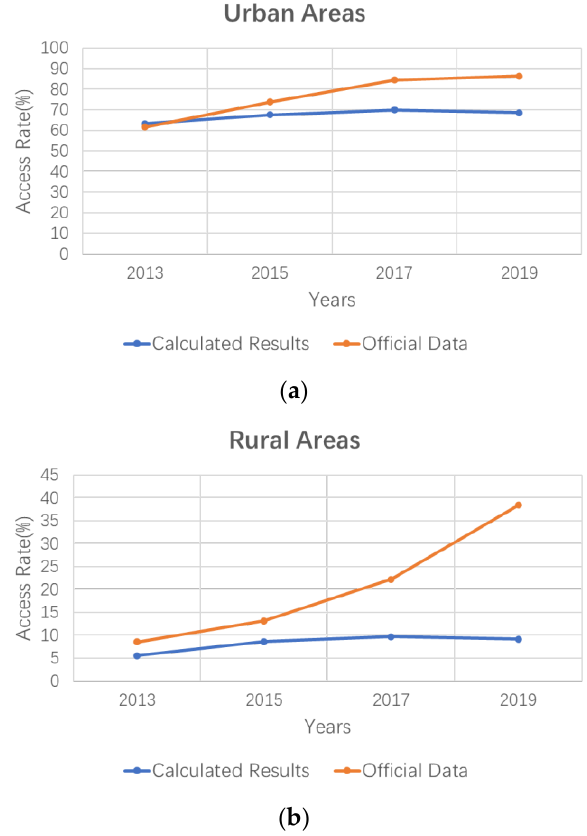
Figure 21. Comparison between the calculated grid access rates and the official electricity access rate data in: ( a ) urban areas and ( b ) rural areas.